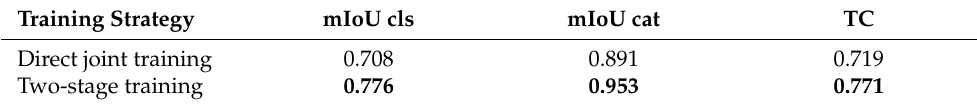
Table 1. The mIoU classes, mIoU categories, and TC of our model under two training